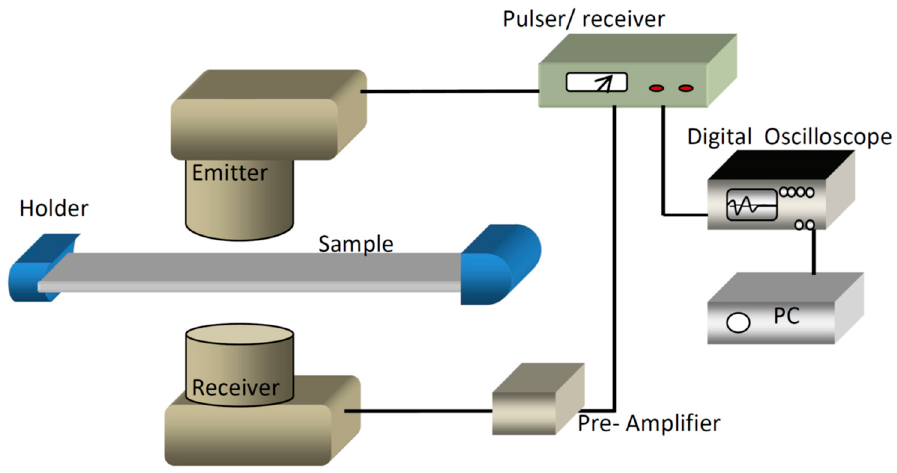
Figure 8. Air-coupled ultrasound technique.